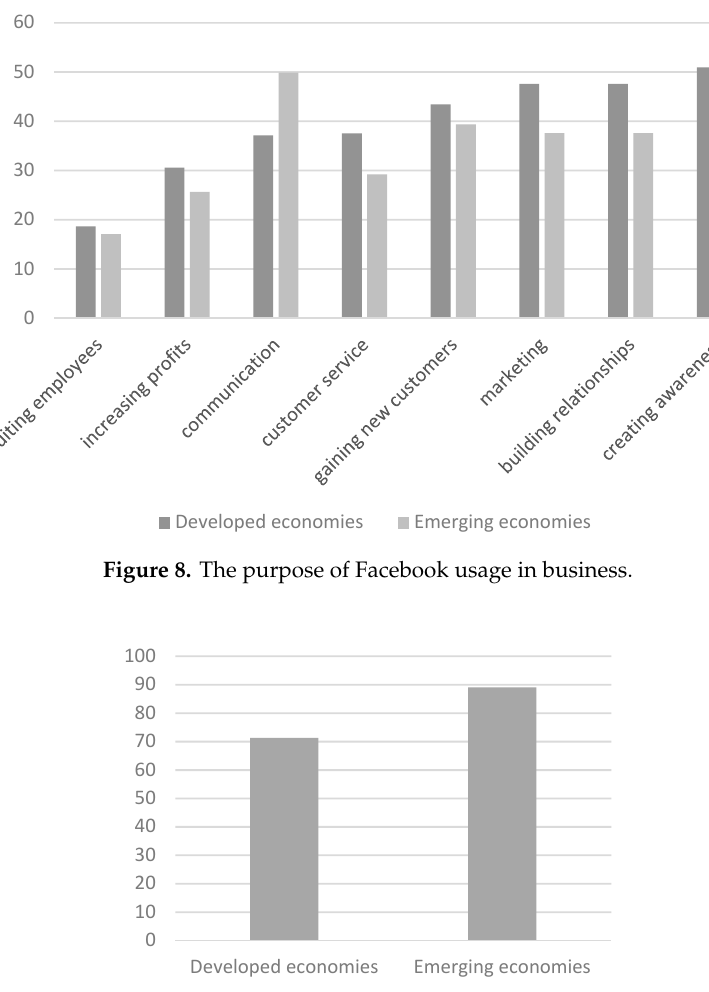
Figure 9. Positive experience with social technologies.